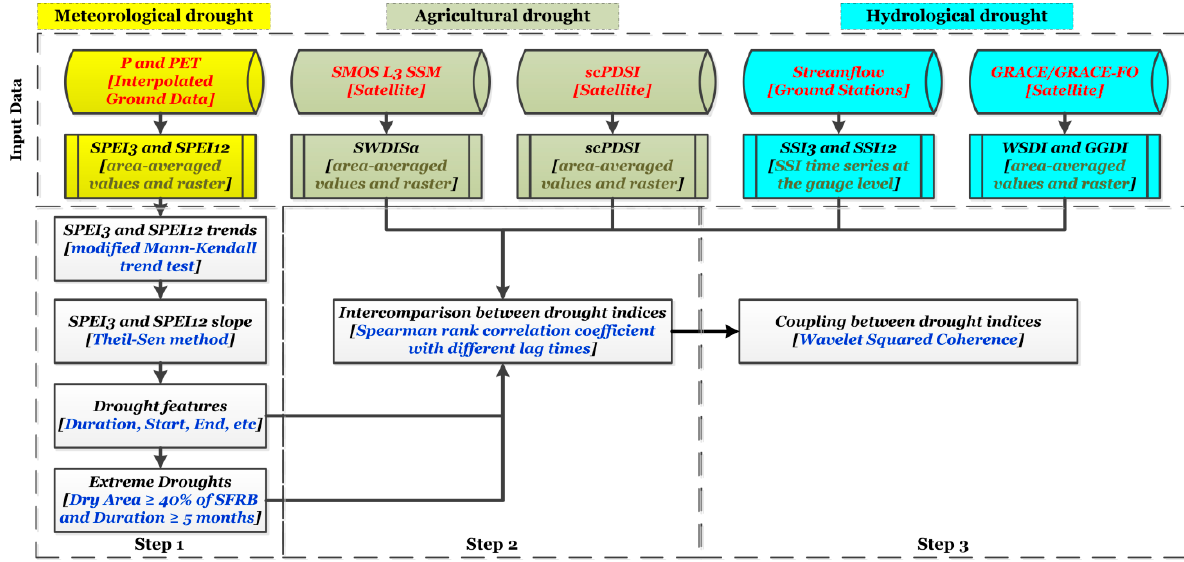
Figure 2. Flowchart of the methodological stages for the study.